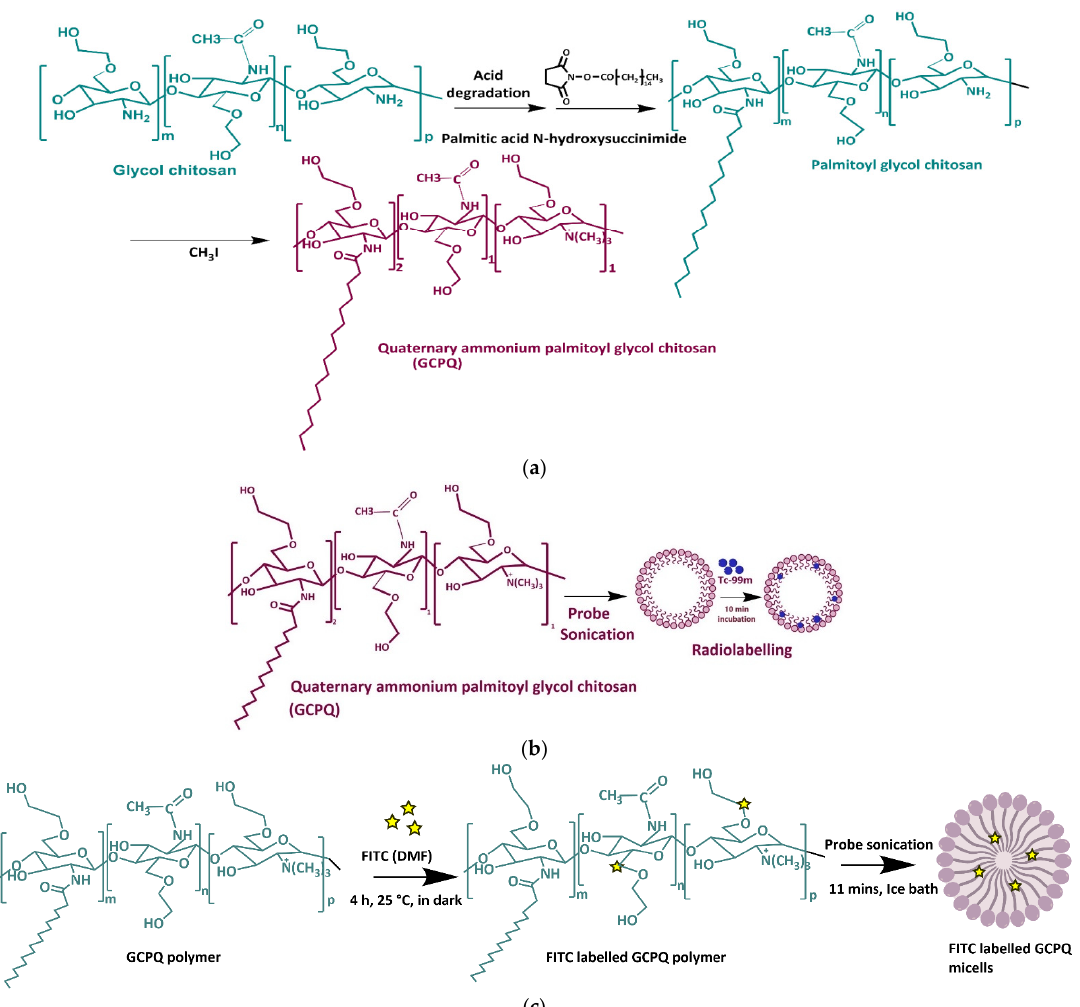
Figure 1. Schematic illustration of glycol chitosan modification, technetium (99mTc) labelling, and fluorescein isothiocyanate (FITC) conjugation. ( a ) Quaternary ammonium palmitoyl glycol chitosan (GCPQ) polymer synthesis scheme; ( b ) GCPQ-99mTc labelling using stannous-chloride-based reduction method; ( c ) GCPQ-FITC labeling; Yellow star represents the FITC molecule.